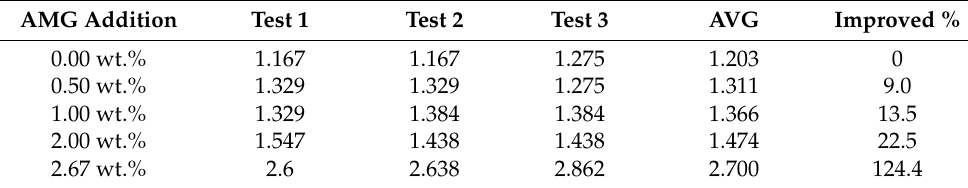
Table 2. Impact resistance test performed according to ASTM D256. AMG